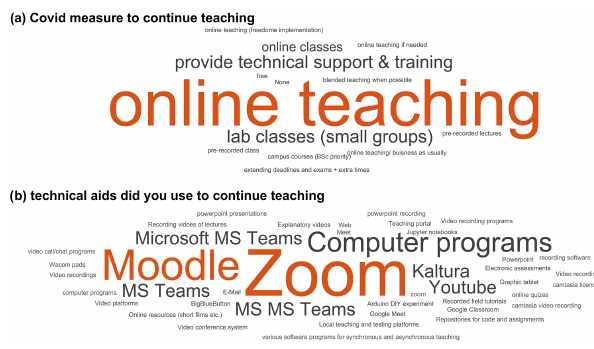
Figure 5. Measures (a) and technical aids (b) used by the respon- dents to continue teaching. The larger the font, the more respon- dents indicated using the measure or aid (multiple answers were